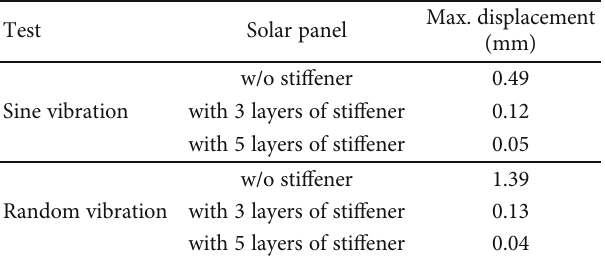
Table 5: Estimated dynamic displacement of solar panels in vibration